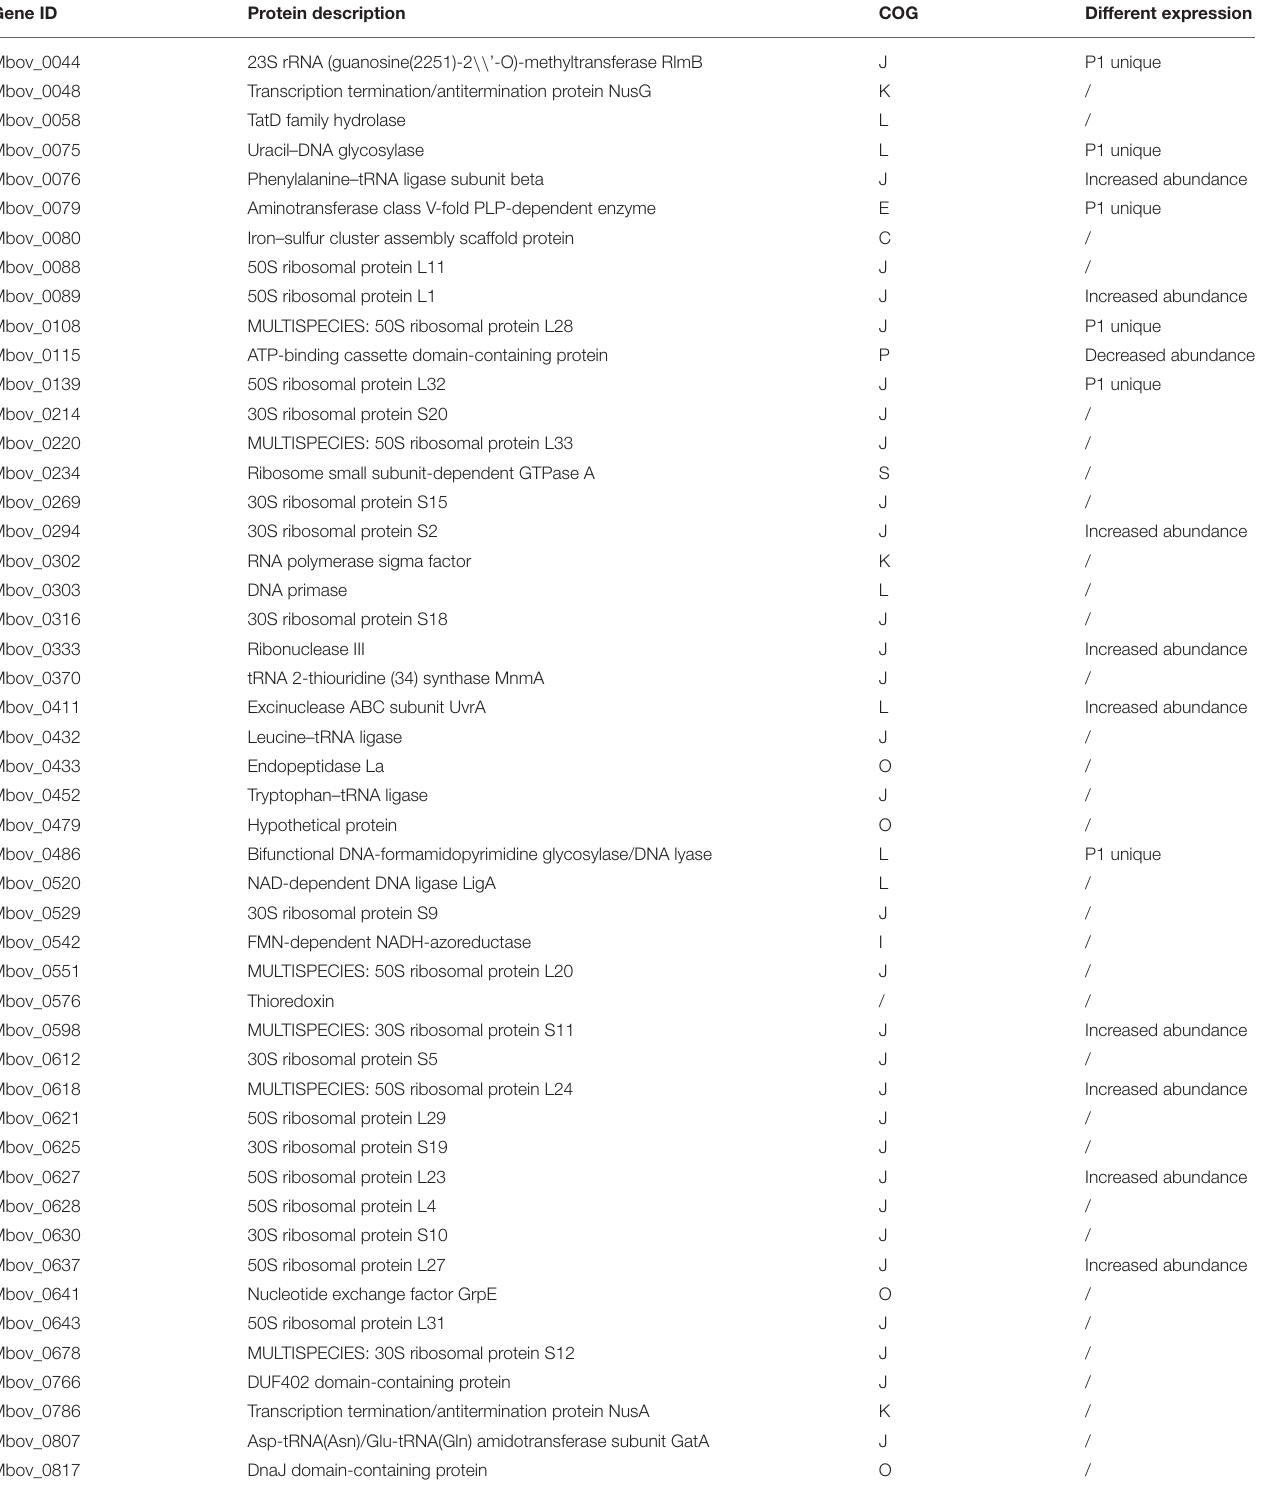
TABLE 2 | The core secreted proteins encoded by 49 core genes of 13 mycoplasmas. Gene ID